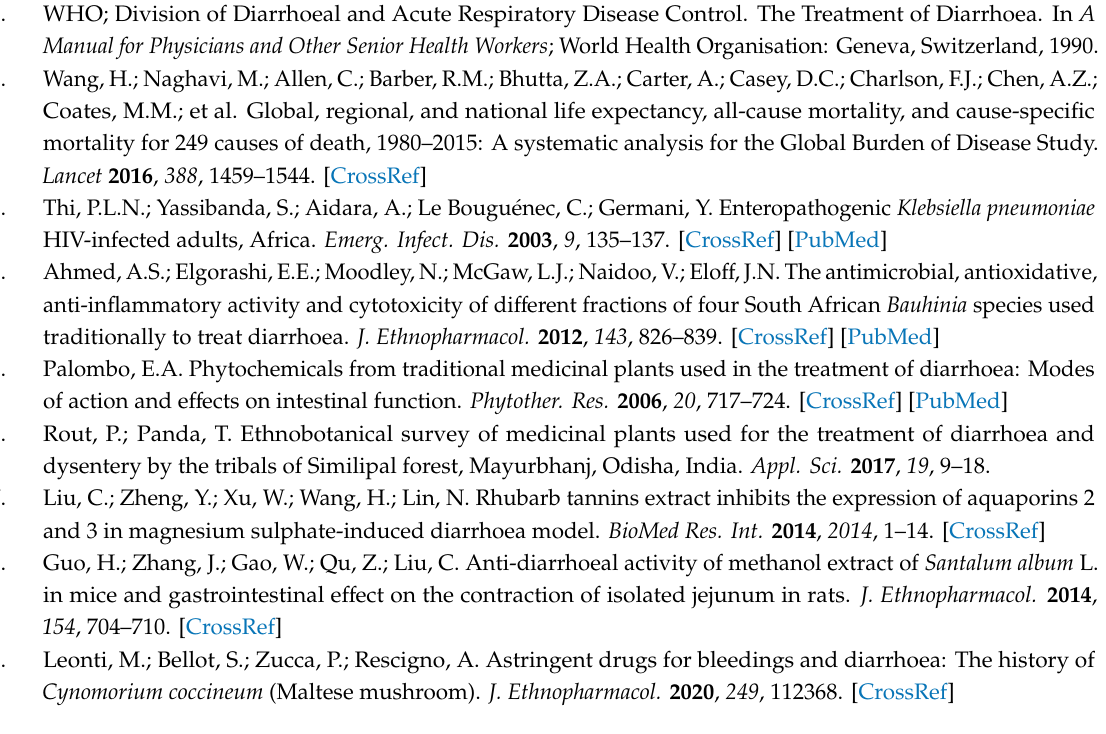
Table S1: Minimum inhibitory concentration values (MIC, mg / mL) of aqueous extracts of Protea ca ff ra screened against drug-sensitive and -resistant bacterial strains; Figure S1: GC-MS chromatogram of a cold ethyl acetate sub-fraction obtained from methanolic extracts of Protea ca ff ra twigs. a = Phenol 2,4-bis(1,1-dimethylethyl); b = Polygalitol; c = 1,3-Benzenediol, 4-propyl-; d = 1,2-Bis (p-acetoxyphenyl) ethanedione; e = 1-Adamantanecarboxylic acid, 2-propenyl; f = Phenol, 2-methyl-4-(1,1,3,3-tetramethylbutyl)-; g = Phenol, 4-(1,1,3,3-tetramethylbutyl)-; h = Phenol, 2-methyl-4-(1,1,3,3-tetramethylbutyl)-; i = 1-Nonadecanol; j = Phthalic acid, butyl tridecyl ester; k = 1-Heptacosanol; Figure S1.1. Extension of a GC-MS chromatogram (14-16 mins) of a cold ethyl acetate sub-fraction obtained from methanolic extracts of Protea ca ff ra twigs; Figure S2. GC-MS chromatogram of a hot ethyl acetate sub-fraction obtained from methanol extracts of Protea ca ff ra twigs. a = ß-Glucopyranose, 1,6-anhydro-, 1,6-anhydro-; b = Polygalitol; c = 1,3,5-Benzenediol, 4-propyl-; d = 1,3-Benzenediol, 4-propyl-; e = 1-Heptacosanol; Figure S3. GC-MS chromatogram of an acetone sub-fraction obtained from methanolic extracts of Protea ca ff ra twigs. a = Oxalyl acid; b =